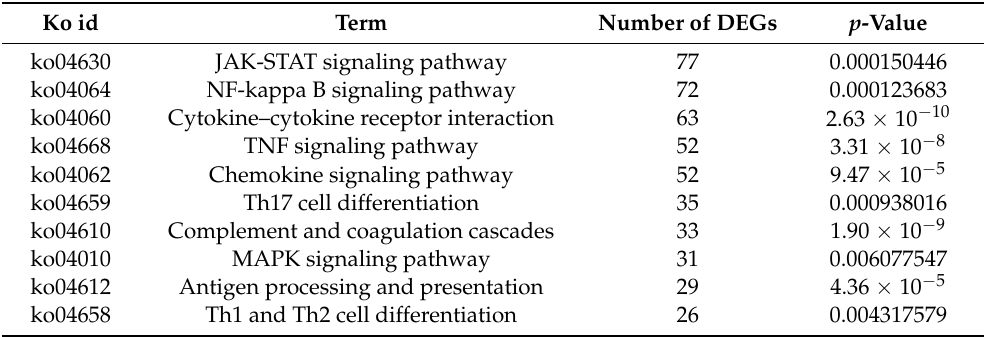
Table 4. Based on KEGG enrichment analysis, ten inflammation-related pathways were significantly enriched. Ko id